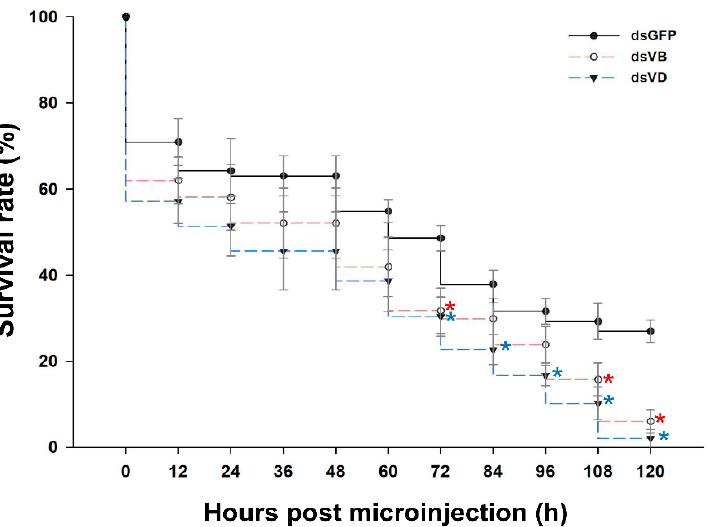
Figure 5. L. trifolii mortality after ingestion of dsRNA. Adults were injected with 100 ng dsV-ATPase B , dsV-ATPase D , or dsGFP (control) and mortality was measured at 12 h intervals. Asterisks represent significant differences between controls and RNAi treatment.